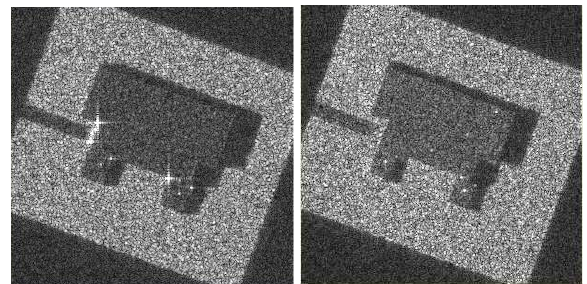
Figure 5: synthetic image for two incident angles: 60 ◦ and 40 ◦